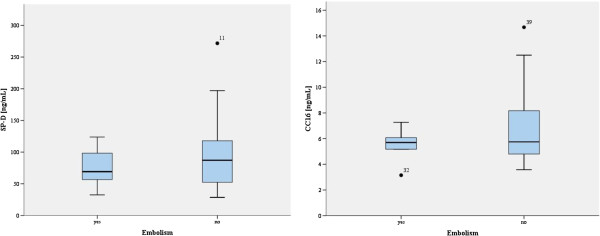
Surfactant protein D (SP-D) and Clara cell protein (CC16) concentration in patients operated in the sitting position with vs. without intraoperative air embolism (VAE). The horizontal line represents the median; the box encompasses the 25th - 75th percentiles (the interquartile range, IRQ), and the whiskers show upper and lower quartiles.